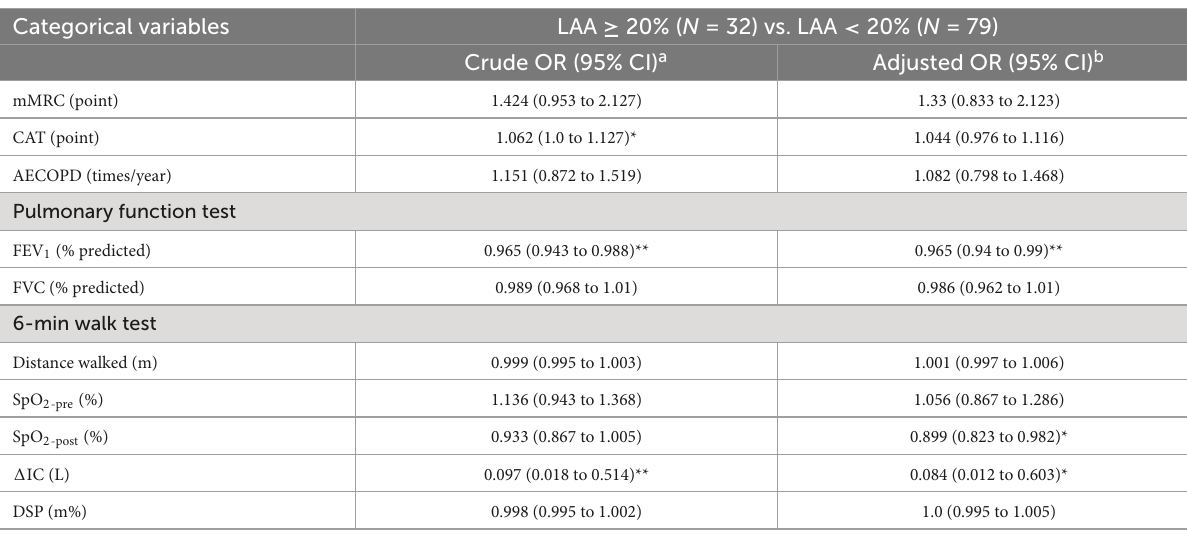
TABLE 4 Associations (odds ratios, ORs) of details of life quality, dyspnea sensation level, acute exacerbation frequency, measurements of pulmonary function test, and the 6-min walk test between patients with and those without severe emphysema [low-attenuation area percentage (LAA%) ≥